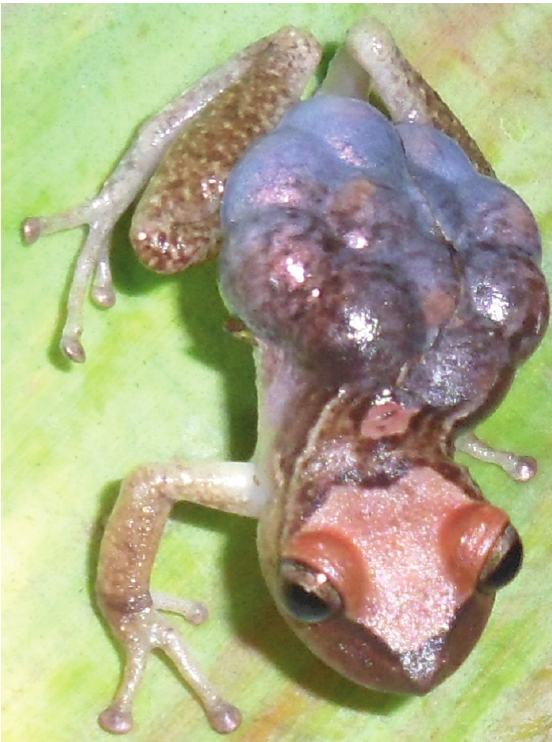
Figure 9. Female Fritziana ulei (ZUFRJ 13337). Note the dorsal colo- ration pattern and the arrangement of the